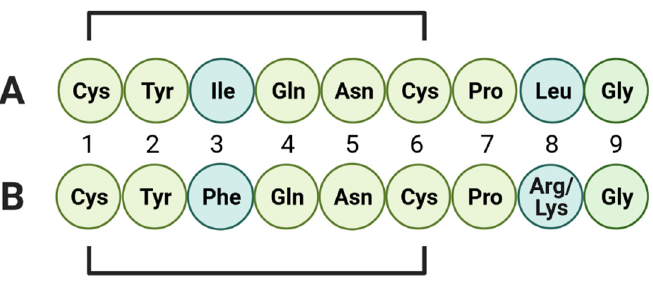
Figure 1. The structure and amino acids sequence of ( A ) OT and ( B ) AVP. The lines indicate cysteine residues that form a sulfur bridge by disulfide bonds. OT and AVP structures differ in the first and eighth place in the aminoacid sequence (dark green). This figure was created with https://biorender.com/ (accessed 10 January 2023).